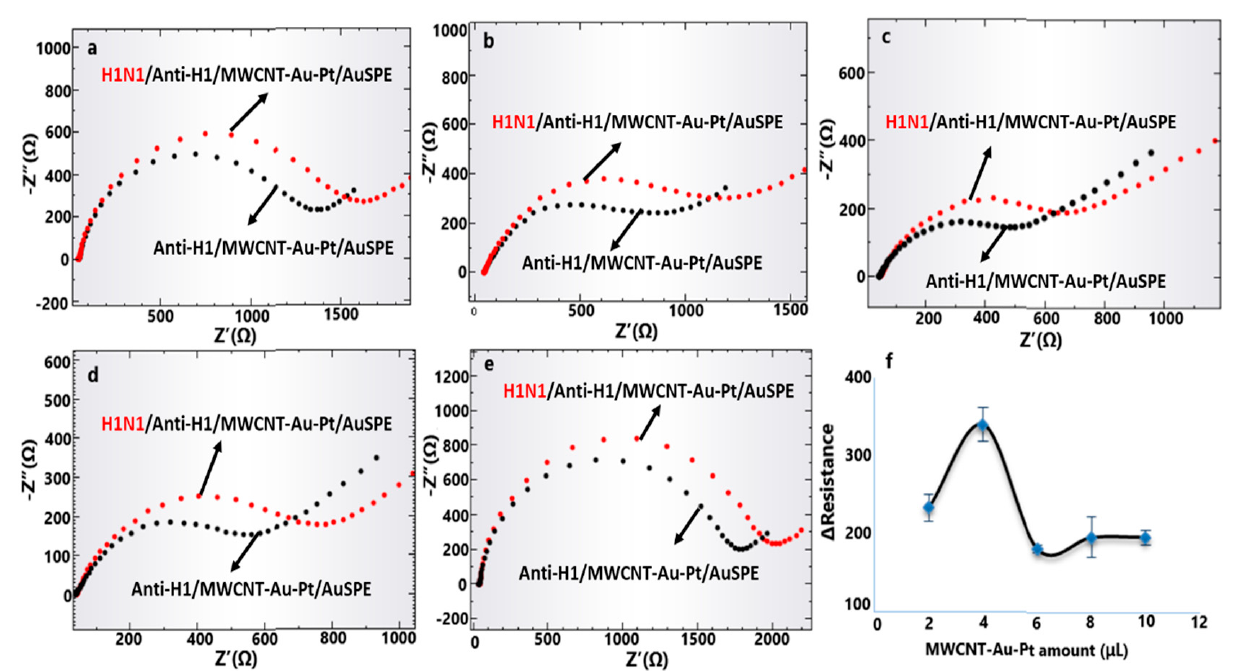
Figure 4. Nyquist plots for electrochemical influenza A immunosensor that contained different amounts of MWCNT-Au-Pt hybrid nanomaterials: ( a ) 2 µ L, ( b ) 4 µ L, ( c ) 6 µ L, ( d ) 8 µ L, ( e ) 10 µ L (10 µ L from 10 mg/mL suspension), and ( f ) change in the resistance values versus increasing the MWCNT-Au-Pt hybrid amount.